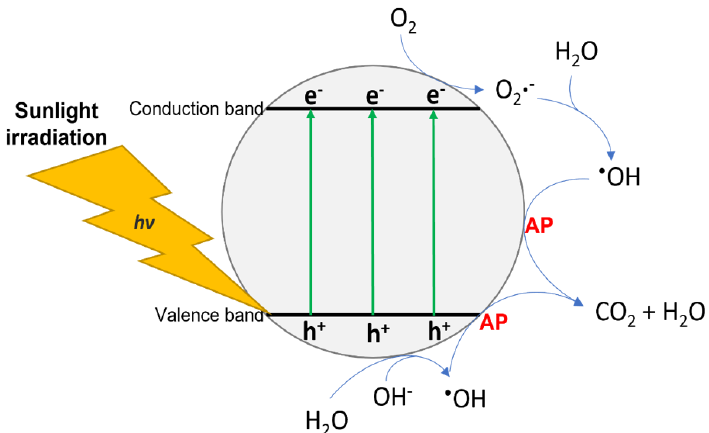
Figure 5. General photocatalytic degradation mechanism. AP—adsorbed pollutant. Represented here with authorization from [75] .